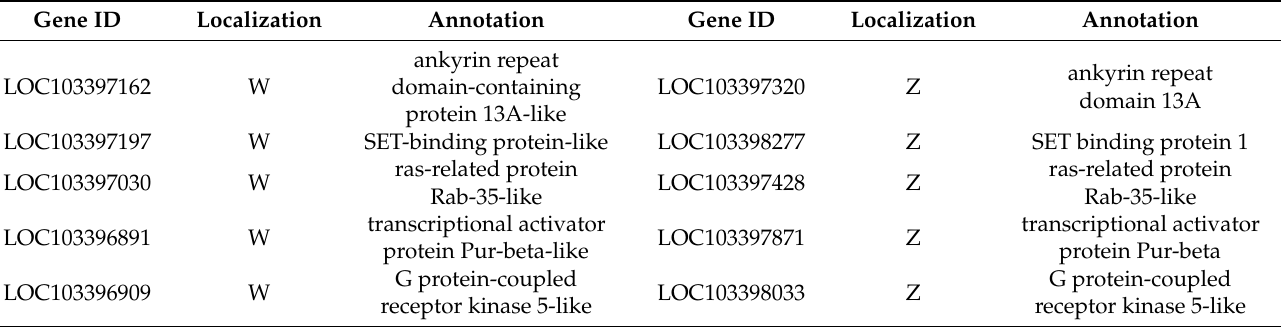
Figure 3. The distribution pattern of sperm DEGs on the Z chromosome. ( A ) The number of DEGs every 1 M. ( B ) Genes localized in the 14 – 15 M region of the Z chromosome. Table 1. Information on five gene alleles on the sex chromosomes.